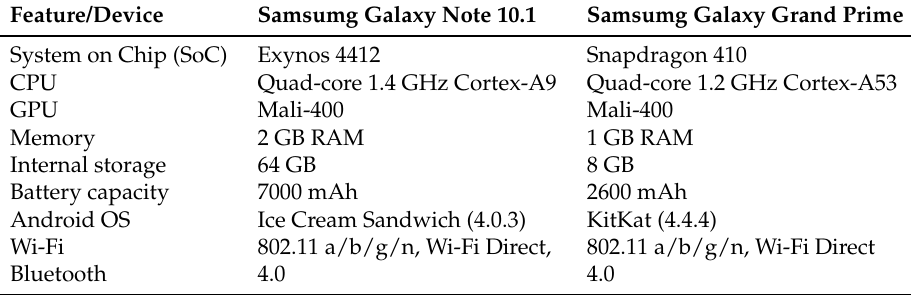
Table 3. Specifications of the devices used in the evaluation.